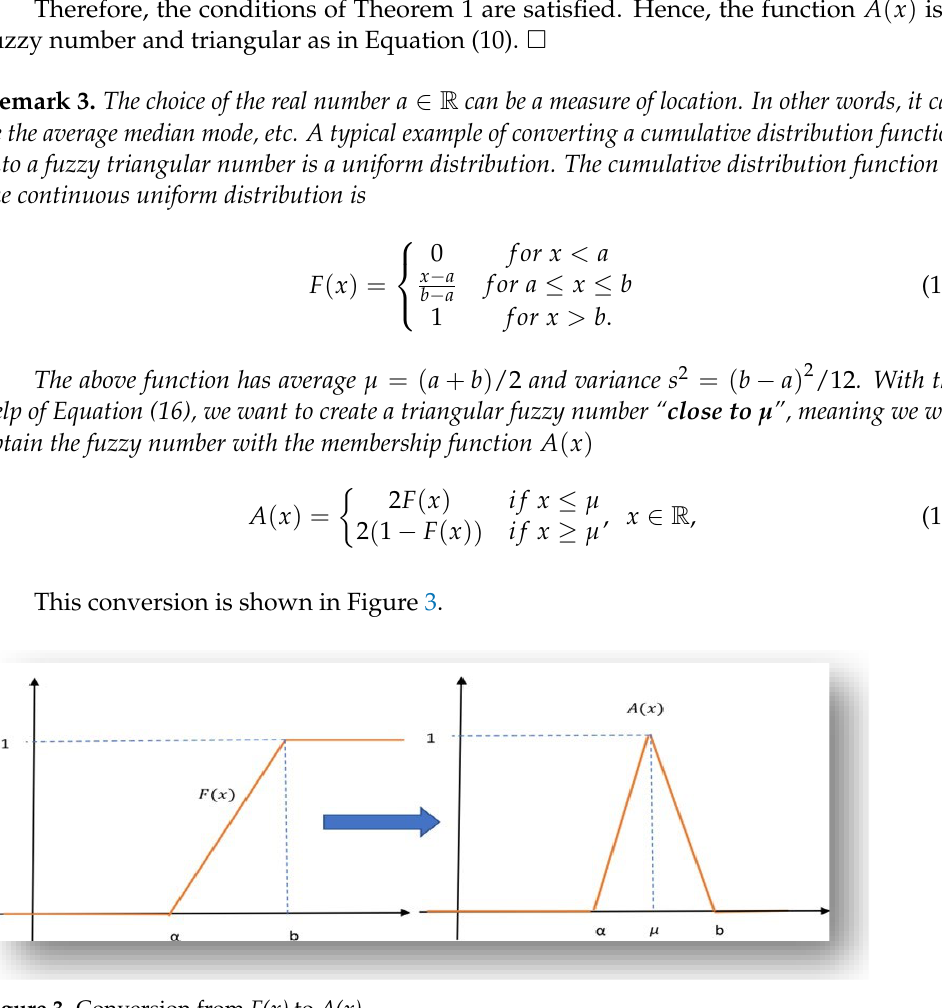
Figure 3. Conversion from F(x) to A(x) .